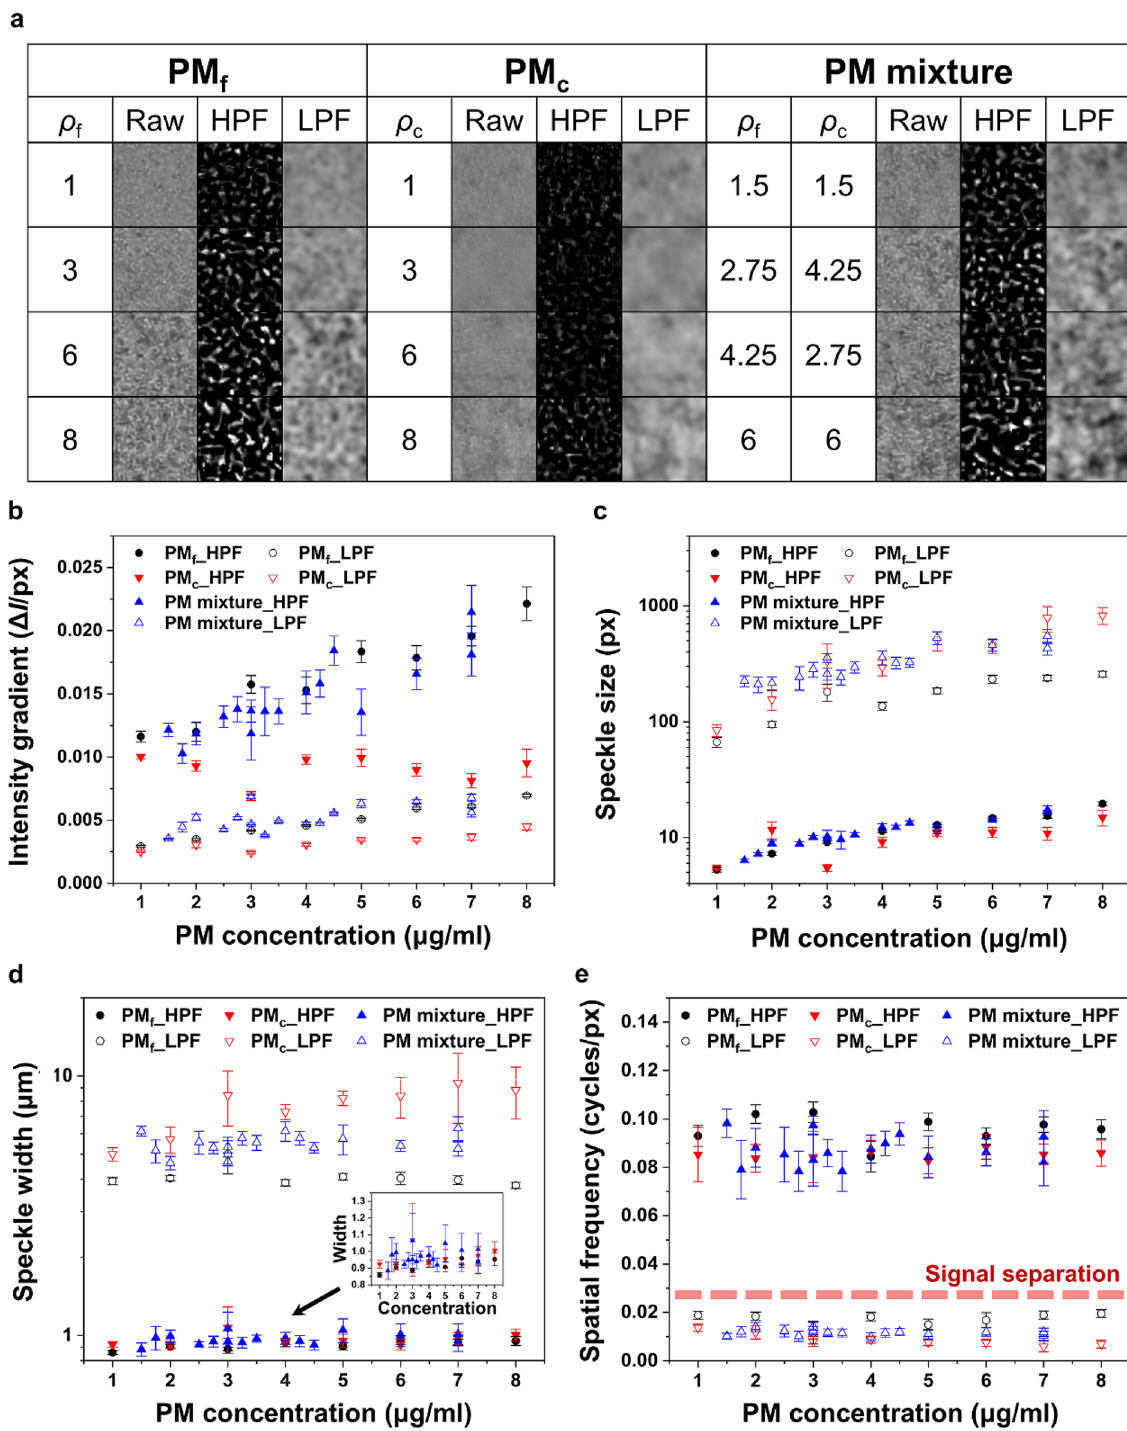
Figure 2. Analyses of various optical characteristics of holographic speckle patterns. ( a ) Typical images of raw, high-pass filtered, and low-pass filtered holographic speckle patterns according to their PM concentration. Comparisons of optical characteristics of holographic speckle patterns: ( b ) mean intensity gradient, ( c ) speckle size, (d) speckle width, and (e) spatial frequency. The dotted red line ( y = 0.0286) denotes the signal separation criterion with the Gaussian filter size R of 20. Segment sizes of speckle images: (Raw, LPF) 35 × 35 μm 2 ; (HPF) 17.5 × 17.5 μm 2